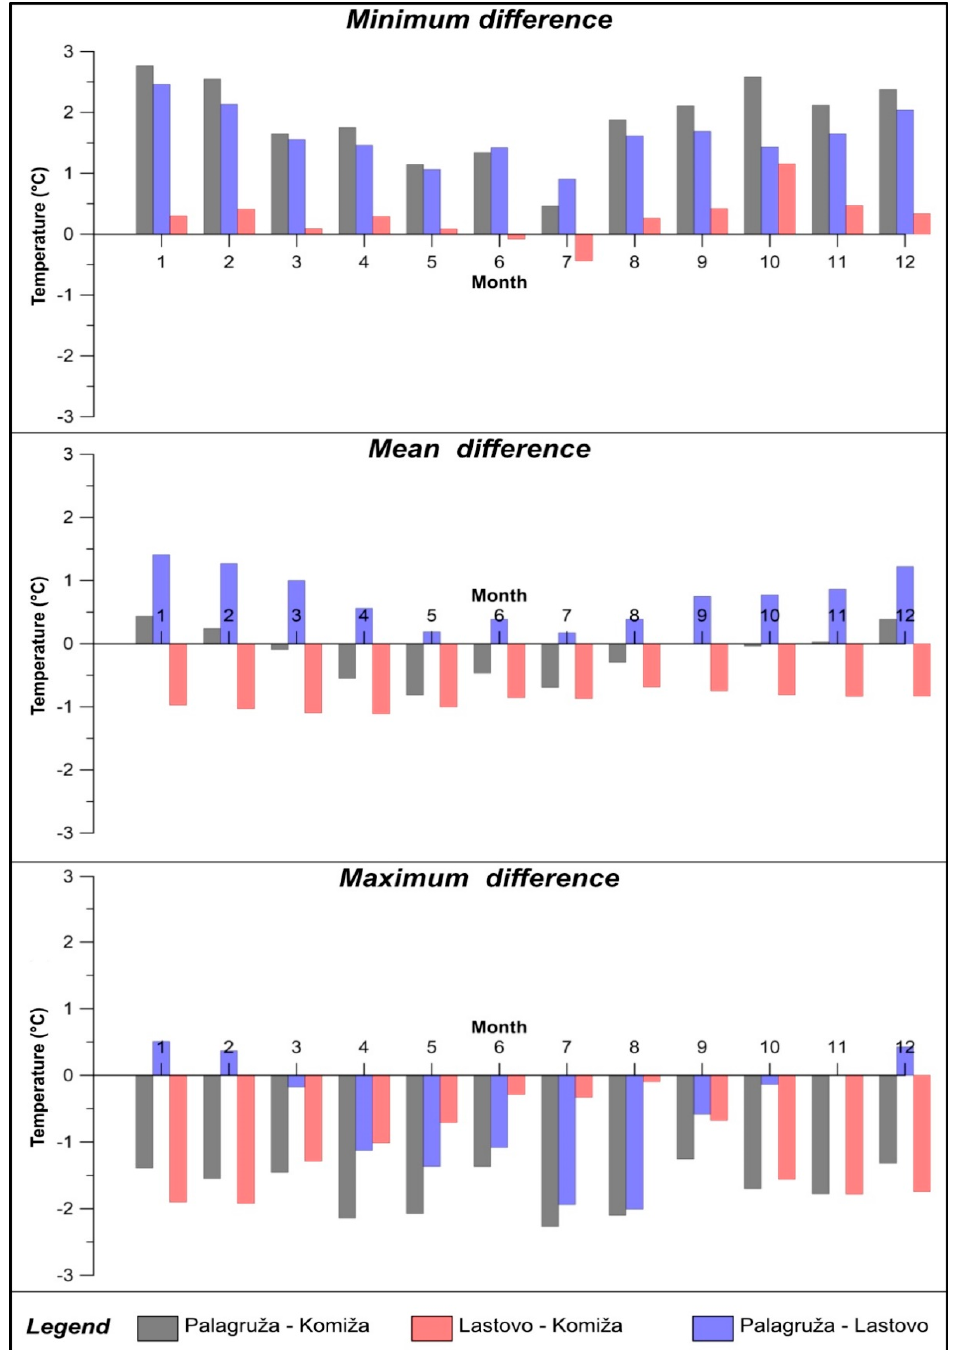
Figure 6. The minimum, mean, and maximum monthly air temperature differences between stations. The differences were calculated based on contemporaneous datasets. Palagruža and Komiža stations (shown in gray), Δ T P-K = av T P − av T K ; Lastovo and Komiža (shown in red), Δ T L-K = av T L − av T K ; and Palagruža and Lastovo (shown in blue), Δ T P-L = av T P − av T L .